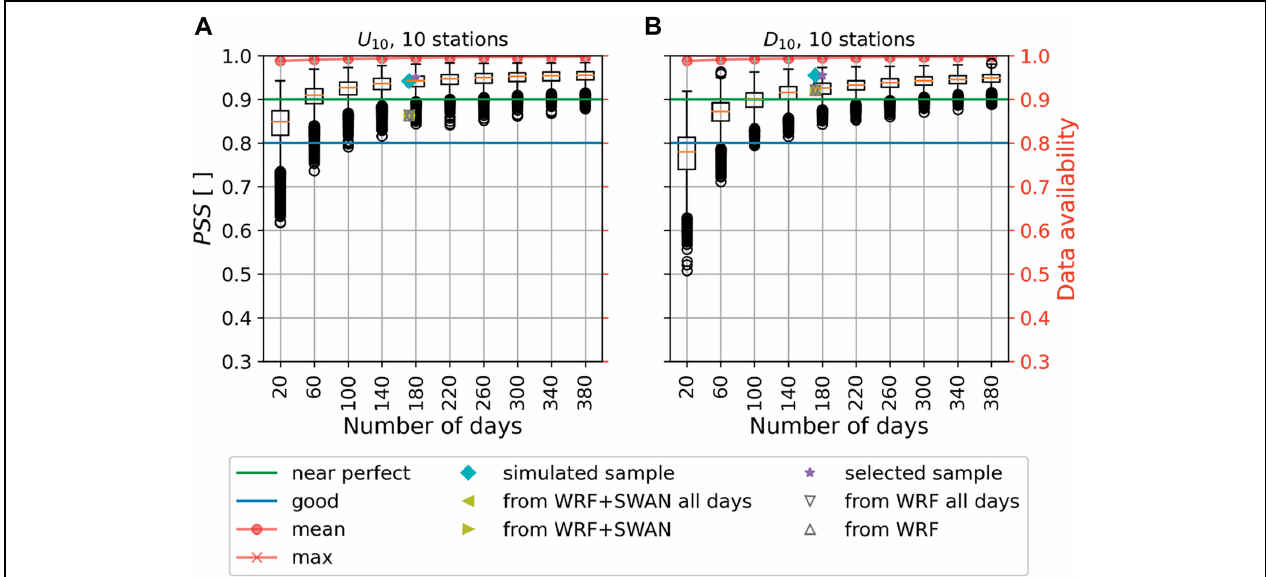
FIGURE 3 | Boxplot for the skill score by Perkins PSS for 10-m (A) wind speed U and (B) wind direction D for all resamples for all base sample stations (black circles in Figure 2 ) along with mean and maximum data availability over all stations. The star indicates the PSS from the selected sample (Section 2.1.3), the diamond the PSS from the simulated sample (Section 2.2) and the triangles the PSS from the simulations (Section 3.1). Note that PSS from all simulations is almost the same and thus all triangles are plotted on top of each other.